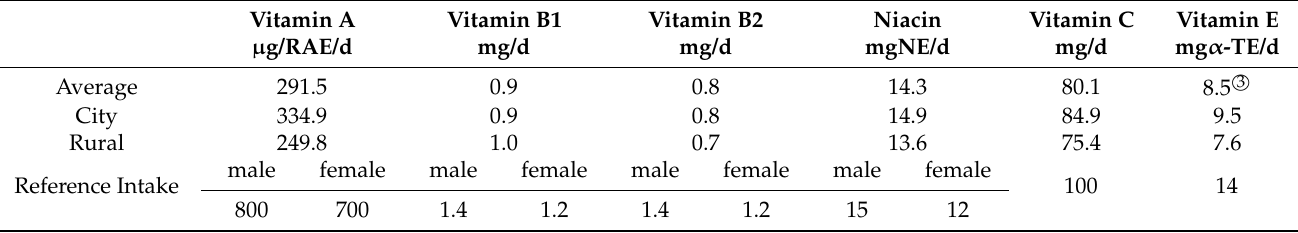
Table 1. The average daily intake of vitamins per standard person for urban and rural residents across the country from 2010 to 2013. The intake of vitamin E uses AI. The data source population represents the reference intake of dietary nutrients for people aged 18–50.